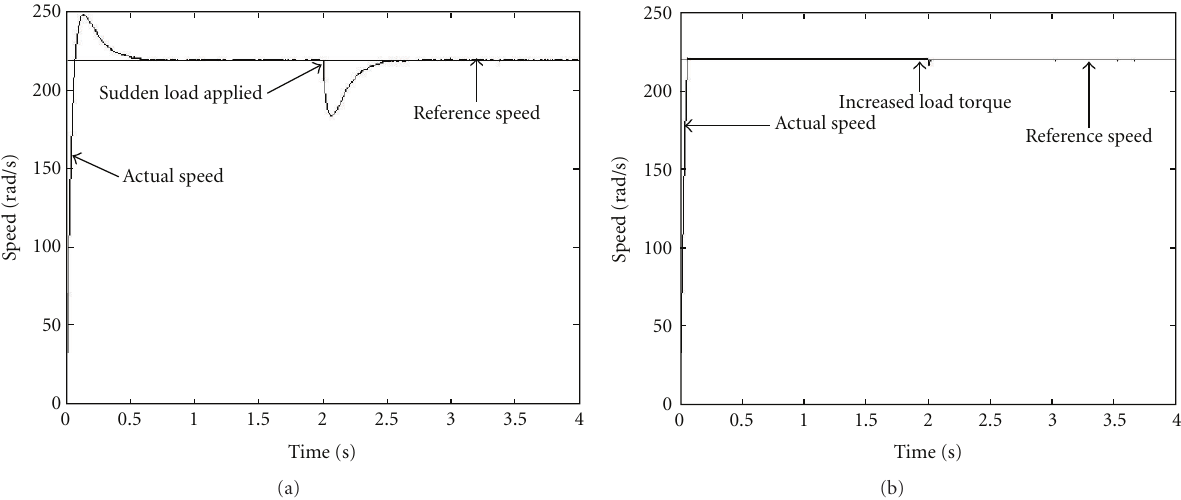
Figure 8: (a) Simulated speed of IPMSM drive for flux-weakening control with reference speed 220rad/sec using PI controller with sudden load applied. (b) Simulated speed of IPMSM drive for flux-weakening control with reference speed 220 rad/sec using fuzzy controller with sudden load